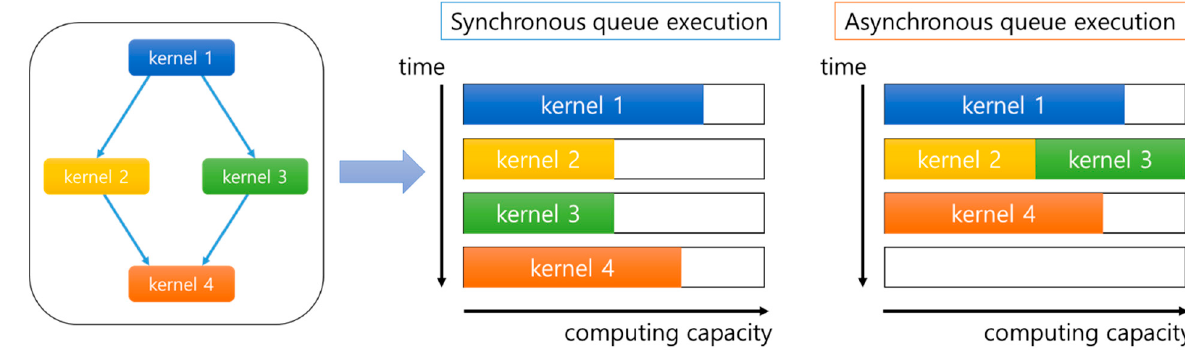
Figure 6. Differences in kernel execution between synchronous and asynchronous queue execution.